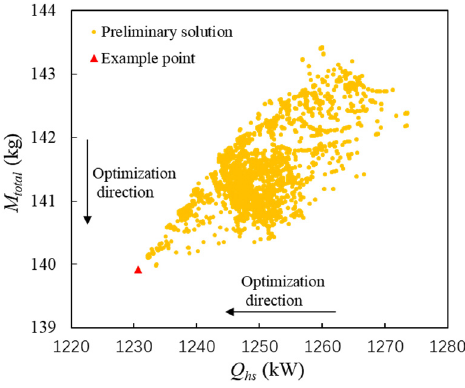
Figure 6. Preliminary optimization solution set and the example point of PTMS.